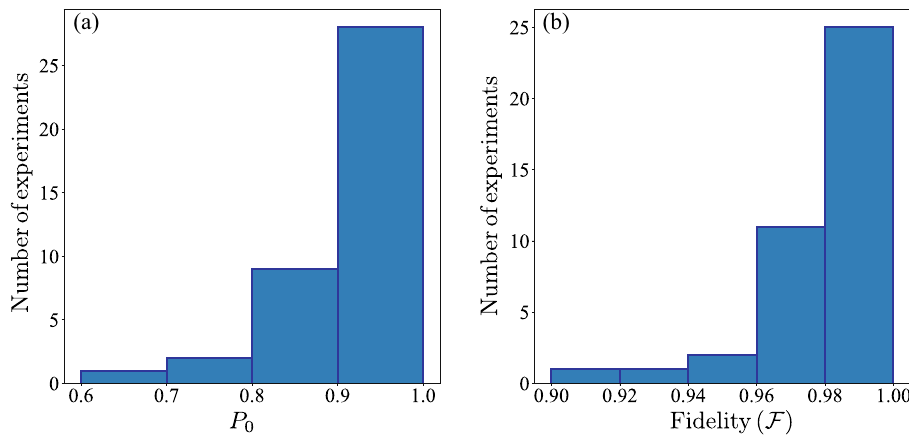
ˆ O = π σ x , r = 0.9 and p = 1 / r . ( a ) 2